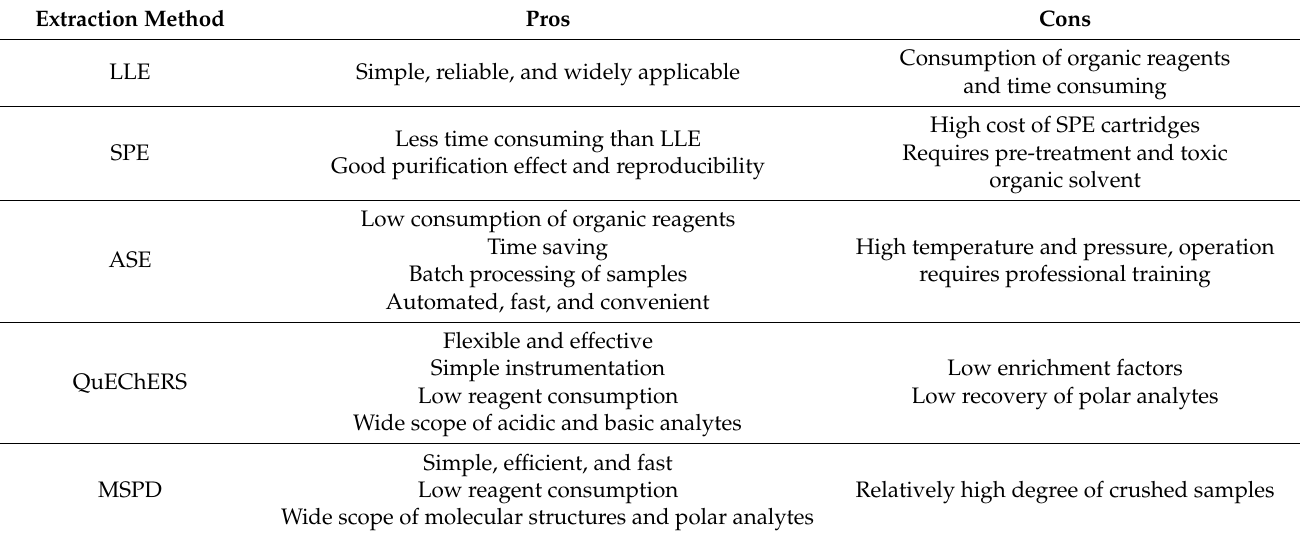
Table 2. Comparison of extraction methods for veterinary drugs (pros and cons). Extraction Method